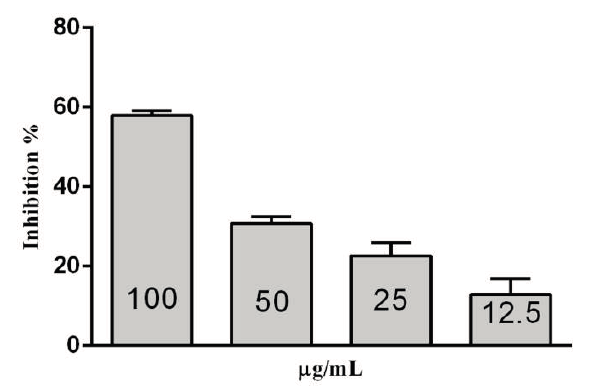
Figure 14. Inhibition of β -glucosidase in S. edule from β -glucose at 90 min